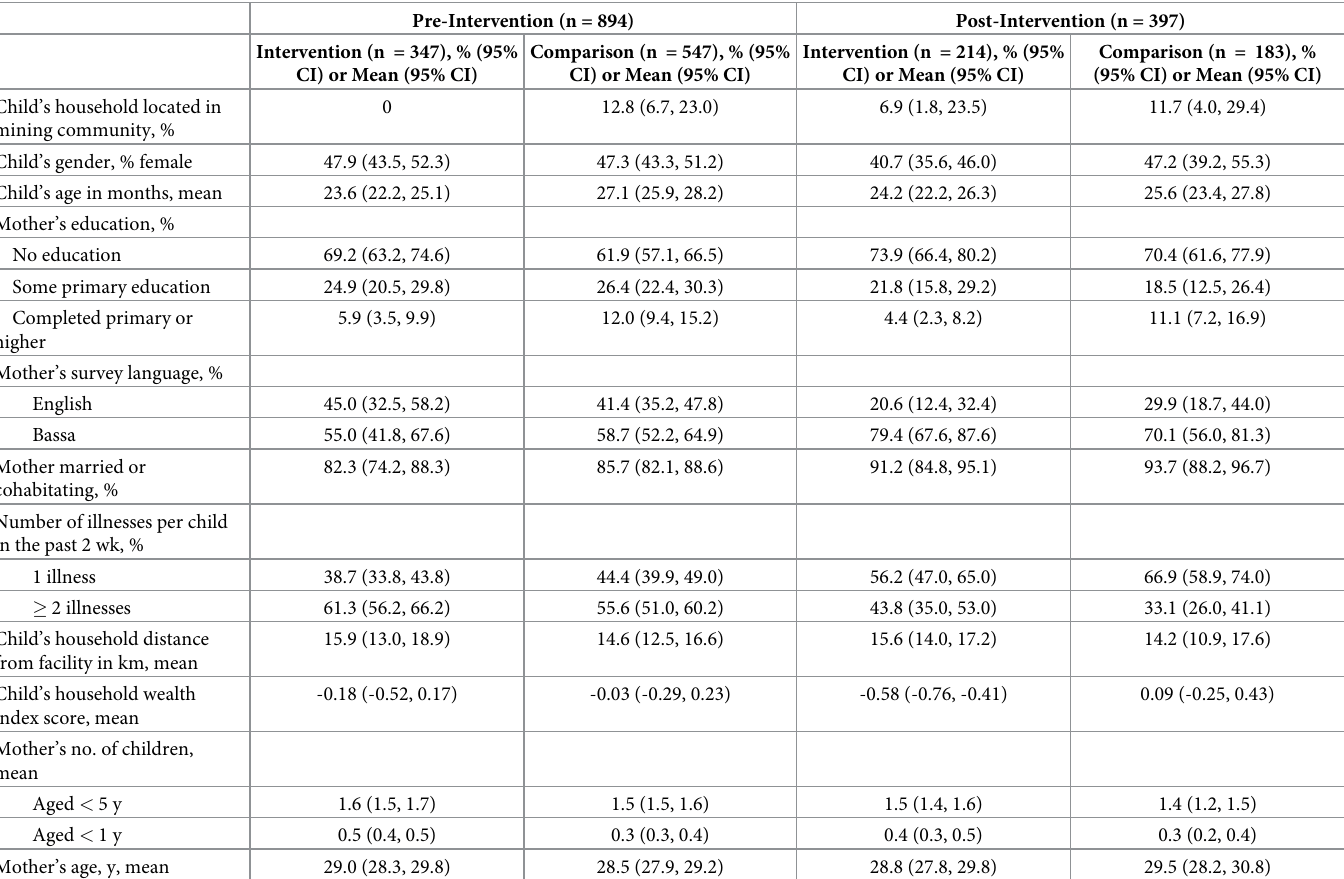
Table 1. Characteristics of children with fever, acute respiratory infection, or diarrhea in the two weeks before the survey (prior to inverse probability of treatment weighting). Pre-Intervention (n =